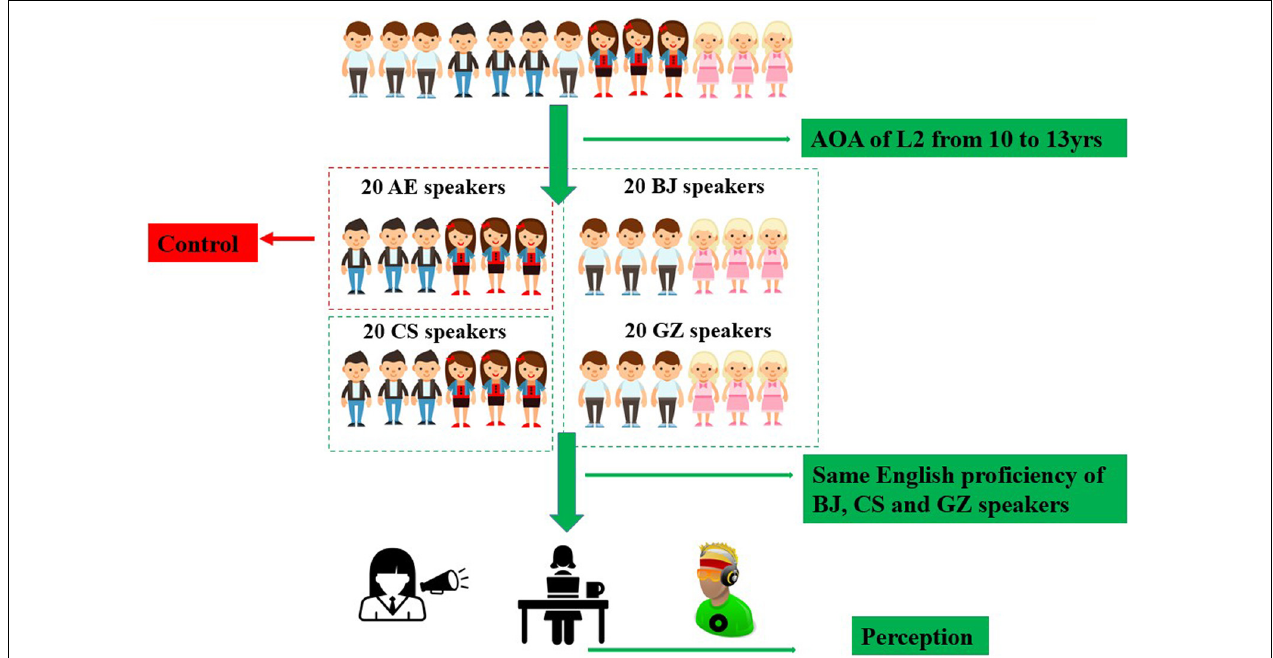
FIGURE 1 | The procedure for selecting